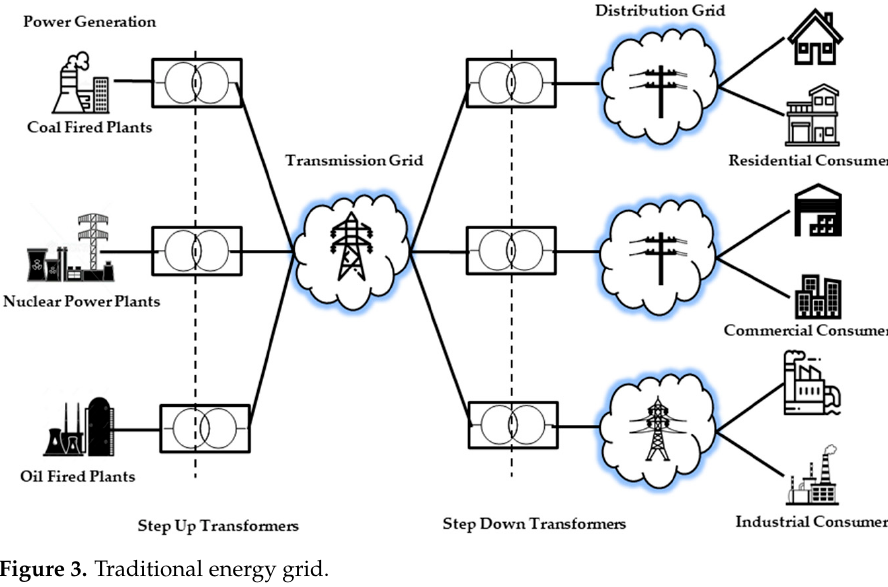
Figure 3. Traditional energy grid.